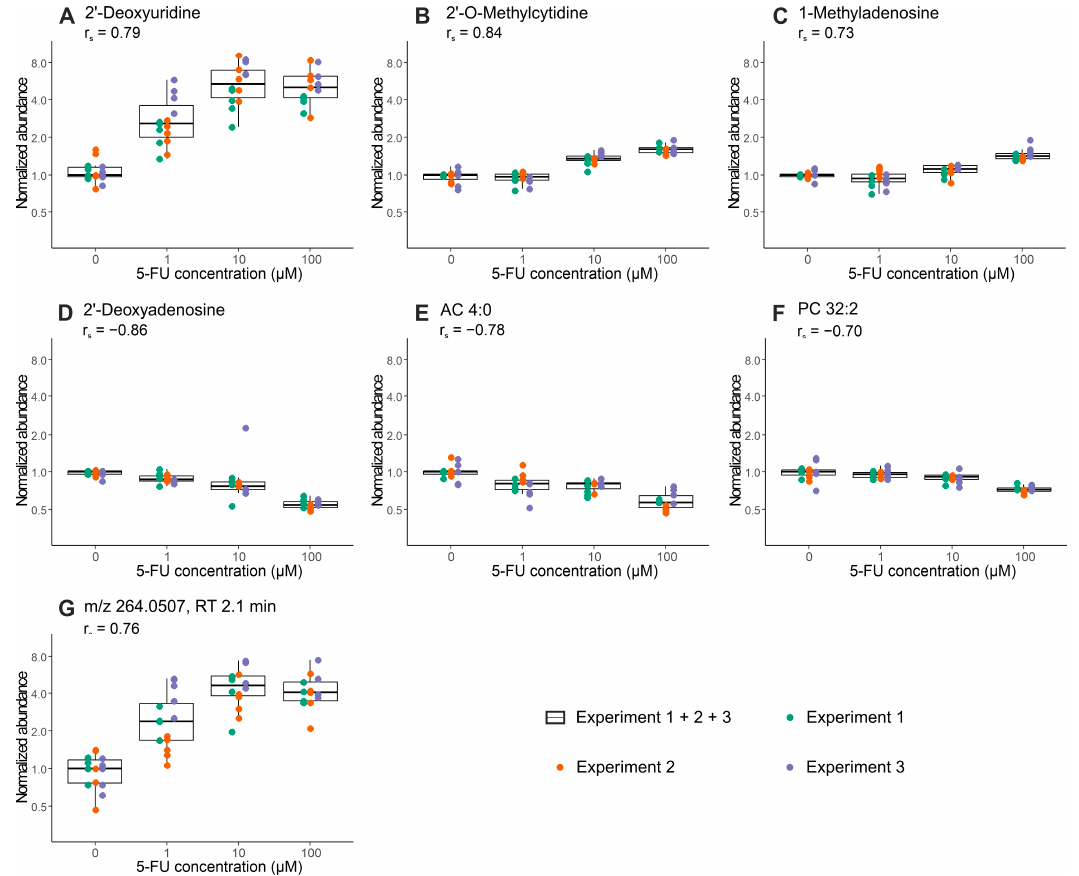
Figure 3. Tukey’s boxplots of dose-dependent changes in metabolite abundance after 24 h of treatment with 5-FU at increasing concentrations assessed in three independent experiments: ( A ) 2 (cid:48) -Deoxyuridine; ( B ) 2 (cid:48) - O -Methylcytidine; ( C ) 1-Methyladenosine; ( D ) 2 (cid:48) -Deoxyadenosine; ( E ) AC 4:0; ( F ) PC 32:2; ( G ) feature m / z 264.0507 eluting at 2.1 min. Overlaid scatter plots represent individual data points ( n = 5 technical replicates, except for 100 µ M experiment 1 ( n = 4)) from all three experiments (experiment 1 (green), experiment 2 (orange) and experiment 3 (purple)). Peak areas of individual features were excluded prior to statistical analysis if the measured value was < 1% of the group median within the corresponding treatment group (max one value per treatment group).